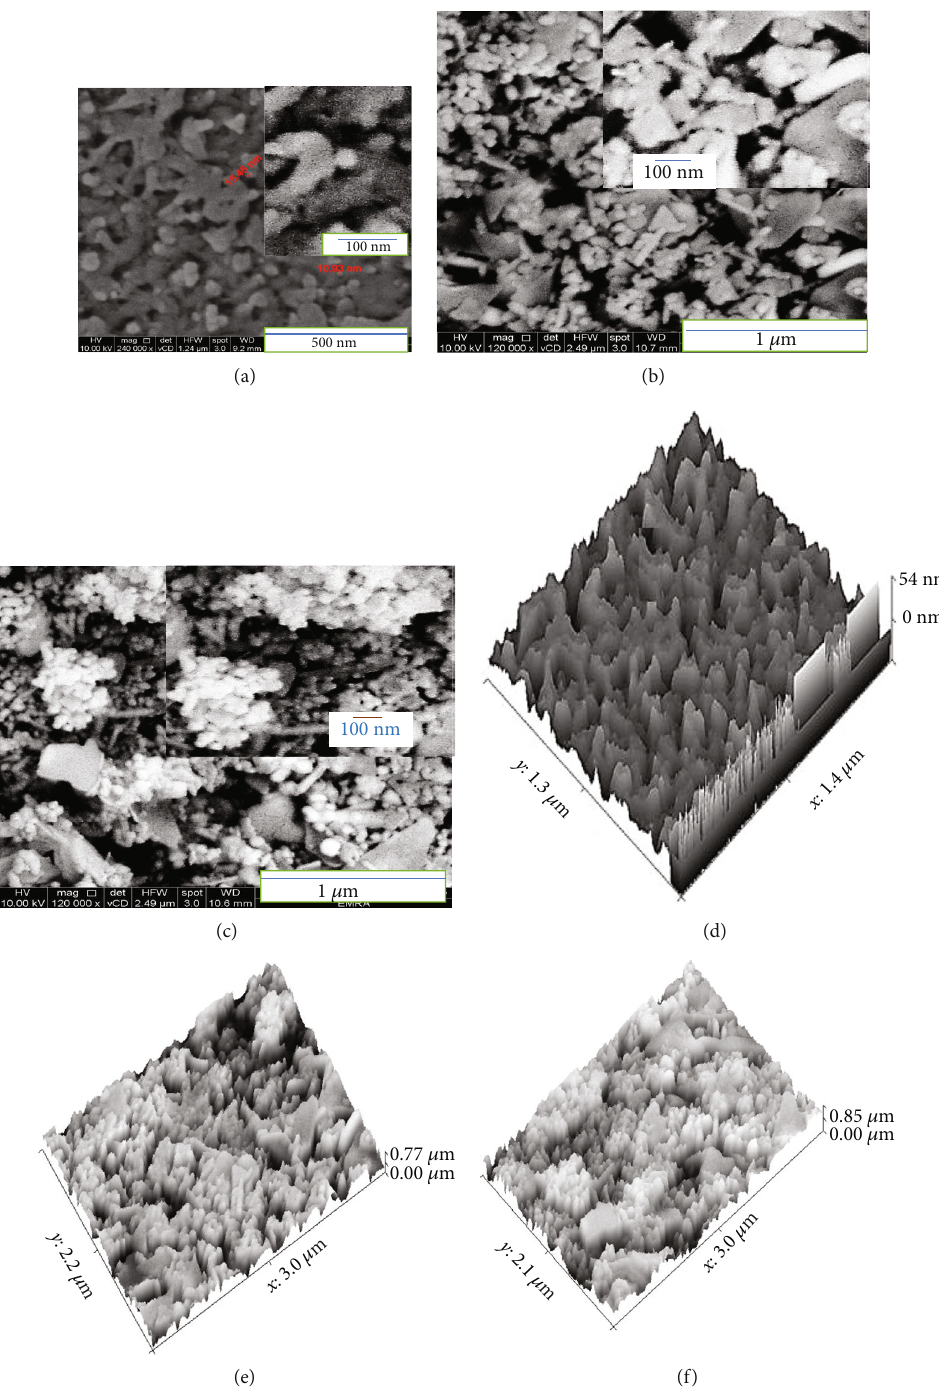
Figure 3: SEM and ImageJ modeling of (a, d) PANI, (b, e) composite I, and (c, f) composite II,